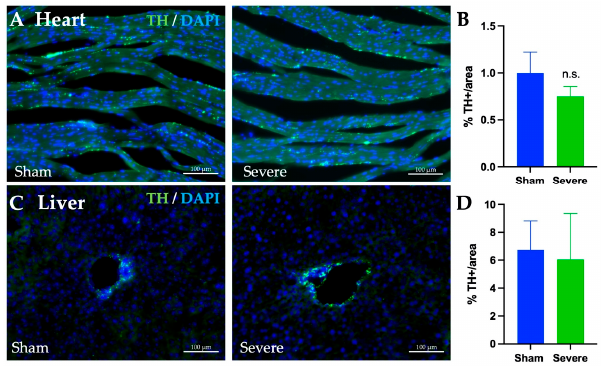
Figure 10. TH staining in the LV and liver. Heart (LVAW, A ) and liver ( C ) 10 µm sections stained for tyrosine hydroxylase (TH) (green) and DAPI (blue) in both sham and sever SCI models. Heart sections from both sham and severe SCI were analyzed for % area of positive TH stain ( B ). No